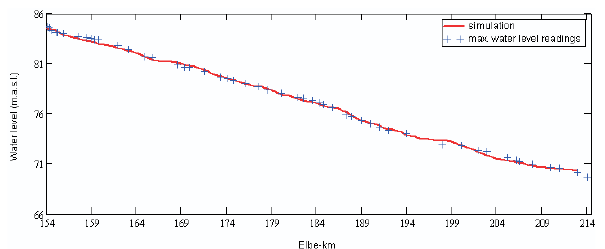
Fig. 8. Longitudinal profiles of the simulated and recorded values of the highest water levels attained along the course of the Elbe River between Torgau and Wittenberg during the August 2002 flood event.